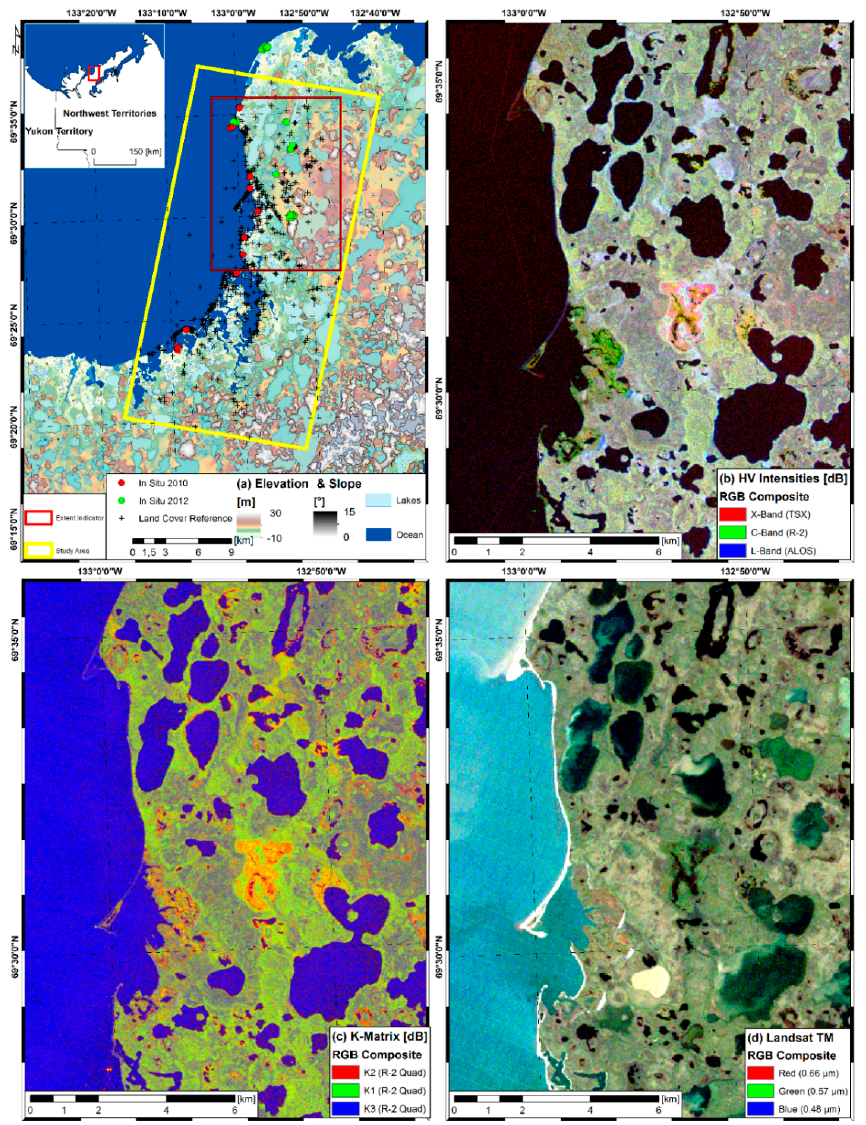
Figure 1. Location of the test site: Tuktoyaktuk (Northwest Territories, Canada) and RGB composites of remote sensing imagery: ( a ) elevation and slope of intermediate TanDEM-X DEM, coverage of TerraSAR-X, Radasat-2, ALOS and ALOS-2 imagery, locations of in situ field work in 2010 and 2012, locations of land cover reference samples derived from high resolution ortho-photos, extent indicator of the subsequent sub-figures (red rectangle); ( b ) RGB false-color composite of sigma nought HV intensities [dB] of X-Band (TerraSAR-X, 2011), C-Band (Radarsat-2, 2011) and L-Band (ALOS, 2010); ( c ) RGB false-color composite of Kennaugh Matrix Elements K2, K1 and K3 of quad-polarized Radarsat-2 data (see Section 2.2.2 Polarimetric SAR Data and Decompositions for more details on the Kennaugh Matrix Elements); ( d ) Landsat TM (2011) true-color composite of red, green and blue surface reflectance. RGB channels are stretched linearly between 1 and 99% of the data range.